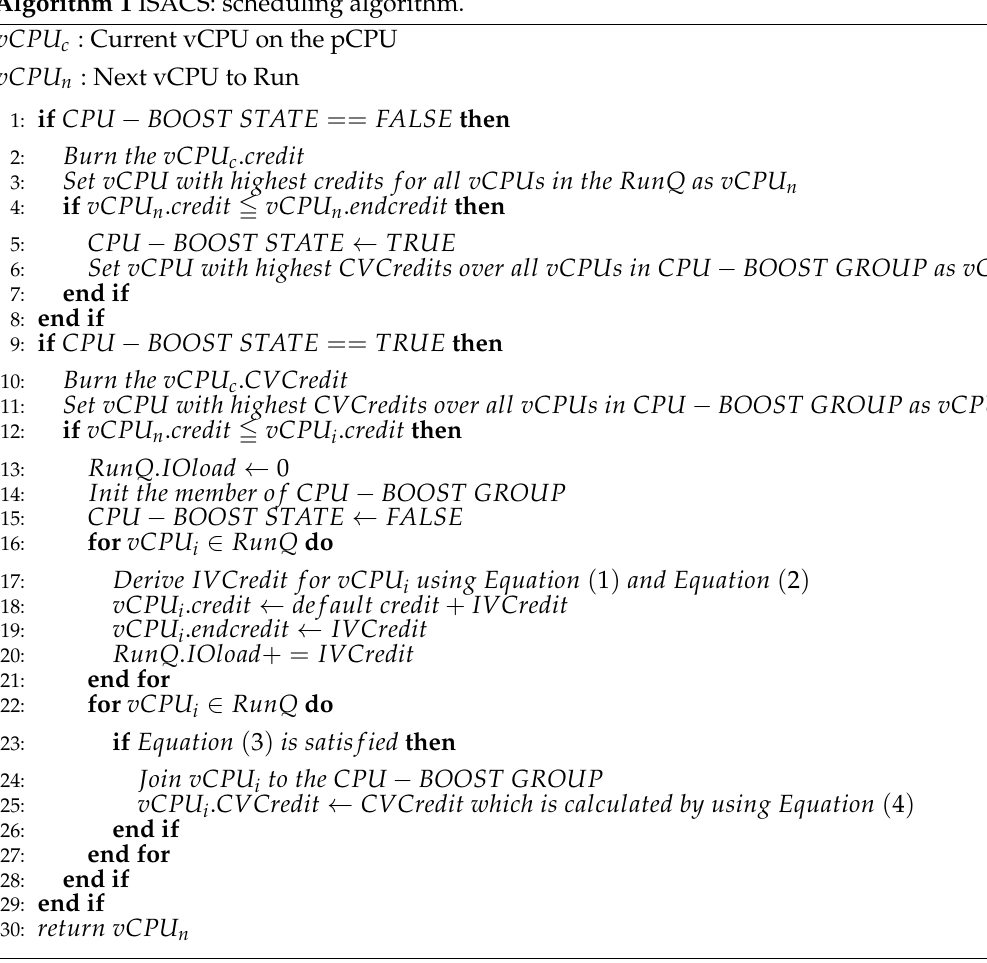
Algorithm 1 ISACS: scheduling